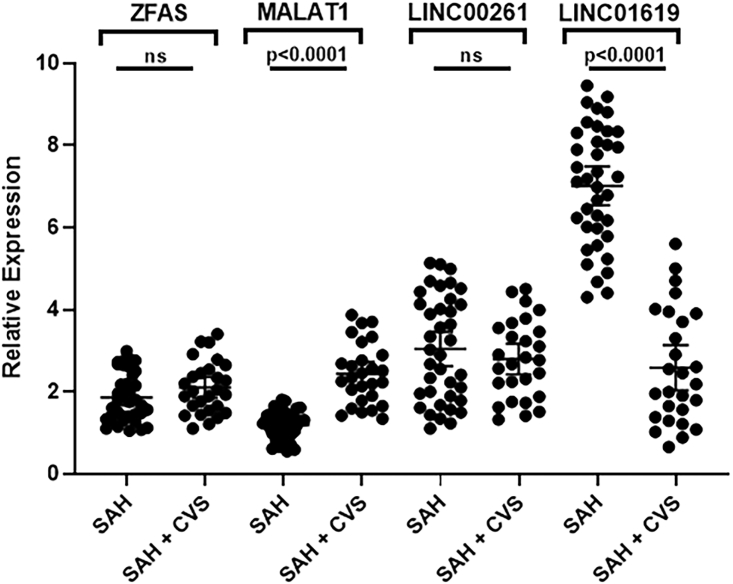
Validation of lncRNA Signature in Archived SamplesExpression levels of lncRNAs ZFAS1, MALAT1, LINC00261, and LINC01619 in individual archived samples are shown. 38 samples were from patients without CVS, whereas 27 samples represented patients with SAH and CVS. Values plotted are mean ± 95% CI. ns, nonsignificant.